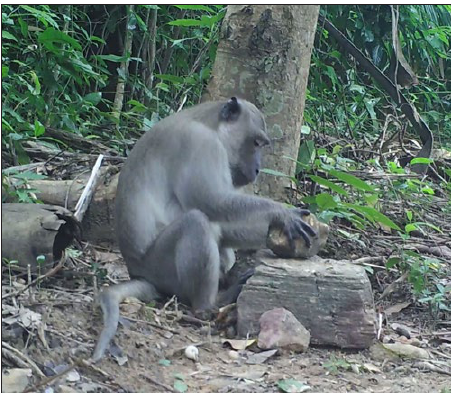
Figure 4: IoA researcher Tomos Proffitt is part of a research team working on primate archaeology. Here, a male long tailed macaque is seen cracking oil palm nuts. (Photo: Lydia Luncz/The University of